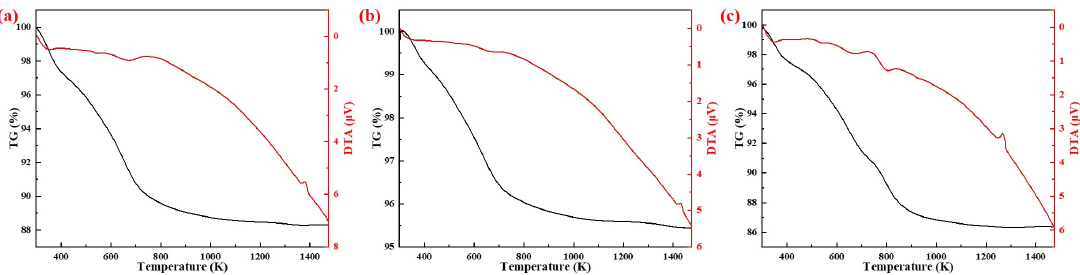
Figure 6. TG-DTA curves of samples from different silicon sources: ( a ) Fly ash; ( b ) Silica dust; ( c ) Gangue.